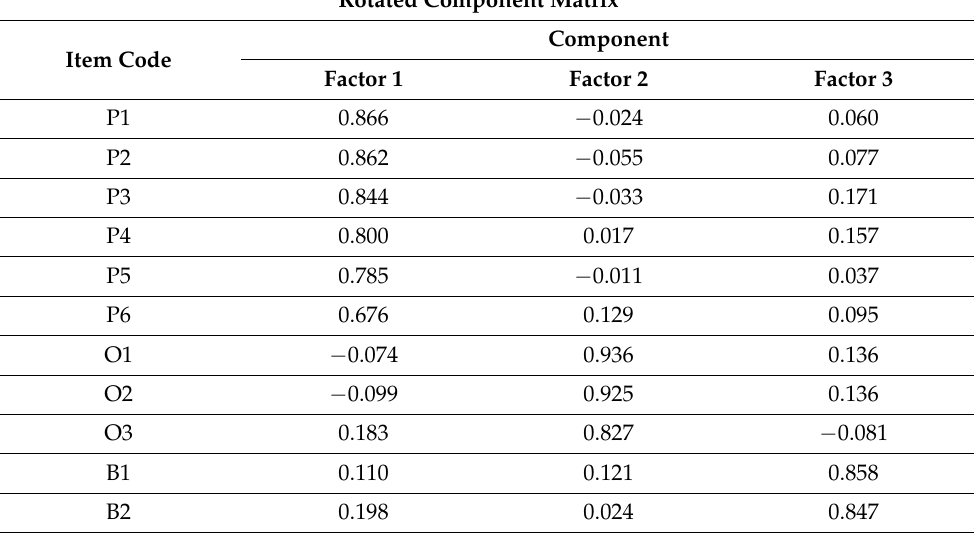
Table 4. Exploratory factor